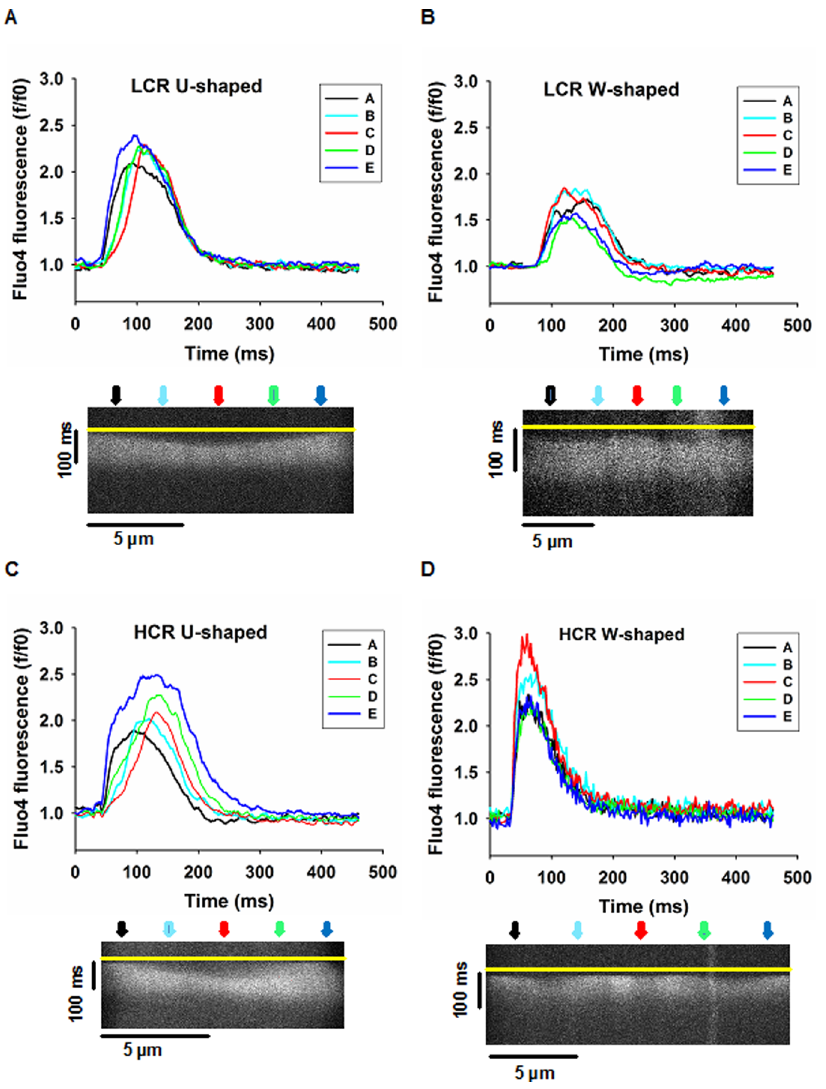
Figure 7. Spatiotemporal characteristics of Ca 2 + transients in isolated atrial myocytes. Cells were labeled with fluo-4 and confocal line scanned transversely. Panels A–D depict the spatiotemporal properties of Ca 2 + transient in: A, atrial myocyte with U-shaped Ca 2 + signal in in Low Capacity Runner (LCR); B, atrial myocyte with W-shaped Ca 2 + signal in LCR; C, atrial myocyte with U-shaped Ca 2 + signal in High Capacity Runner (HCR); D, atrial myocyte with W-shaped Ca 2 + signal in